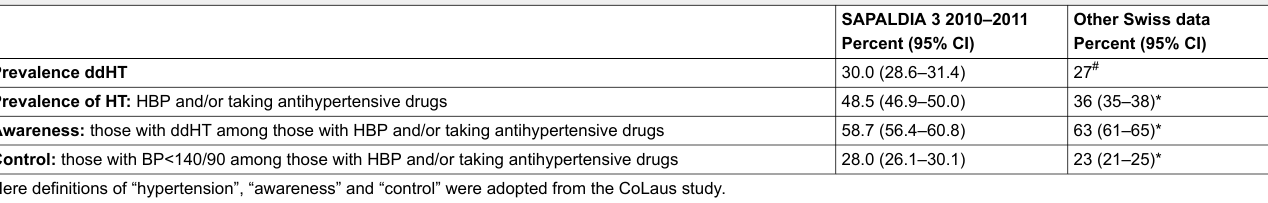
Table S2: Comparison of hypertension prevalence between SAPALDIA 3 and other Swiss data.